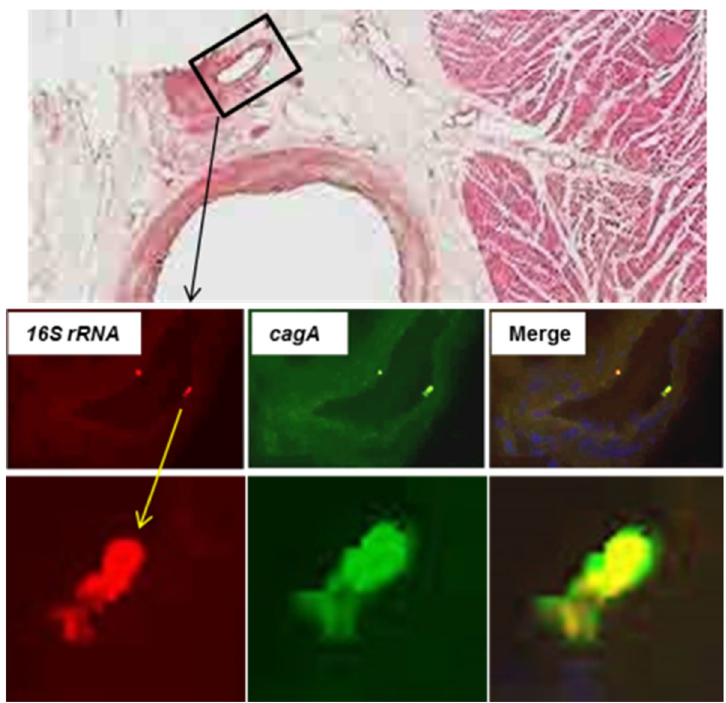
Fig 6. H . pylori attached to the endothelium of a collateral arteriole. Fluorescence in situ hybridization of H . pylori 16S rRNA (red) and cagA (green) was carried out on tissue sections with DAPI staining of nuclei (blue). Top image, boxed area shows the arteriole shown in the lower images. Middle row, 400x; Bottom row, 1,000x.